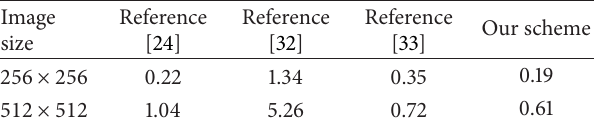
Table 9: Time test